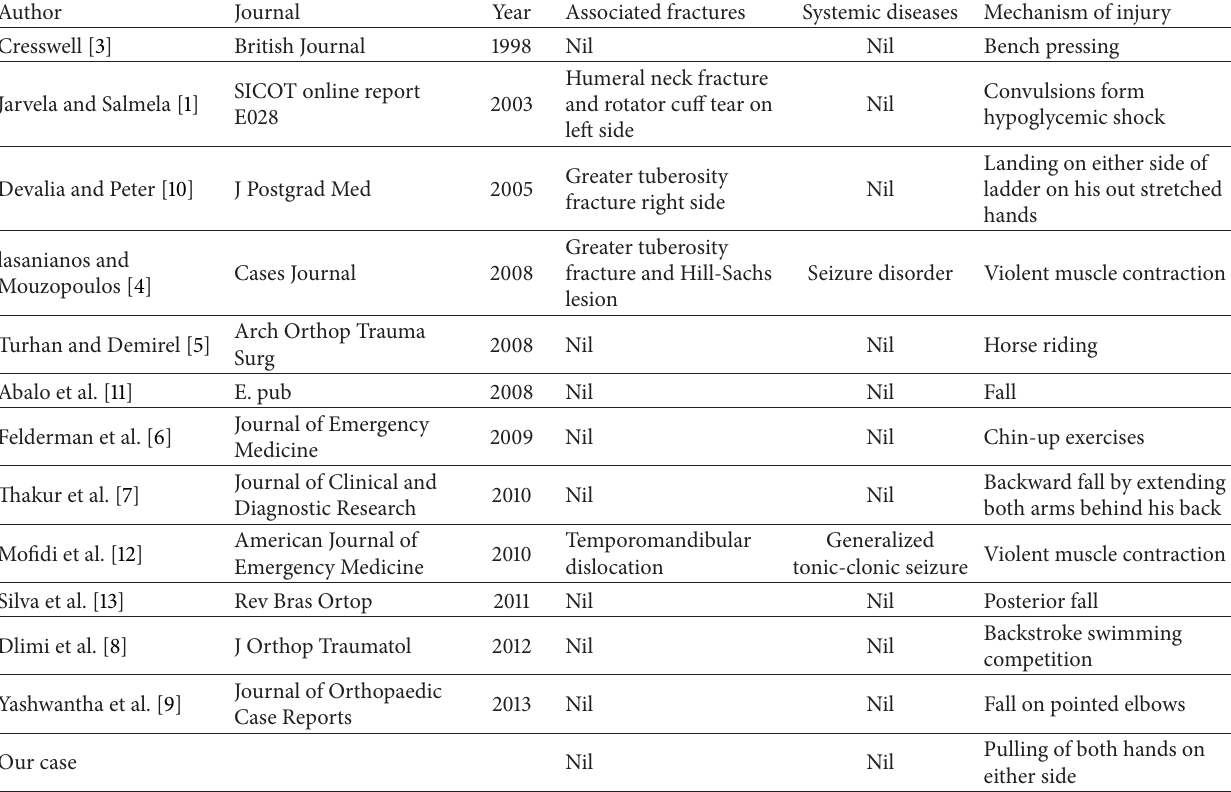
Table 1: Different mechanism of injury in bilateral, simultaneous anterior shoulder